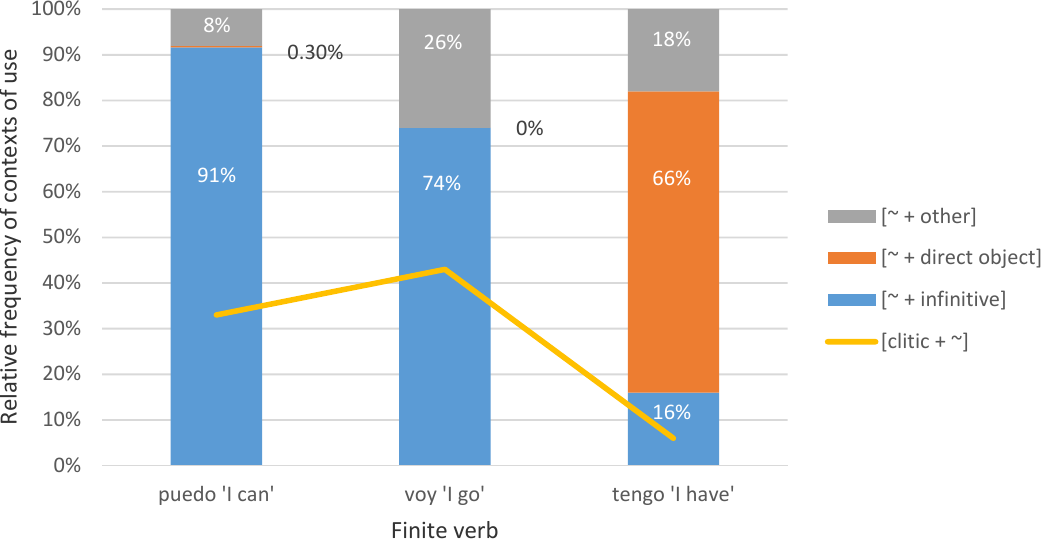
Figure 2. Relative frequency of the 1SG present tense form of each verb followed by an infinitive in Corpus del Español (Davies 2002).